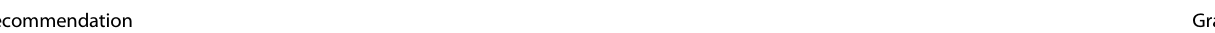
Table 4. Key recommendations